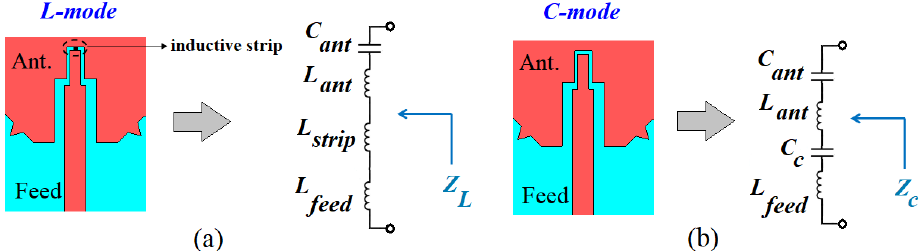
Figure 2. Dual coupling modes (operating modes) of the proposed antenna configuration: ( a ) L-mode and ( b )